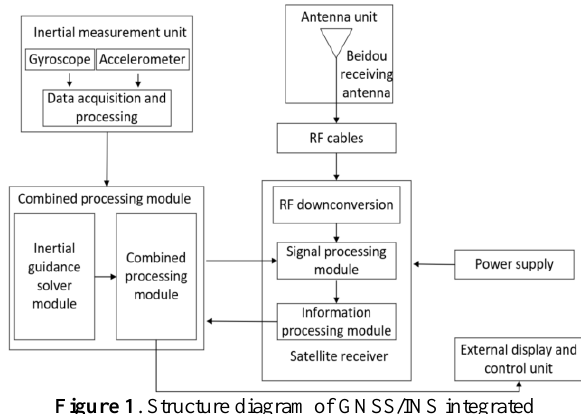
Figure 1 . Structure diagram of GNSS/INS integrated navigation